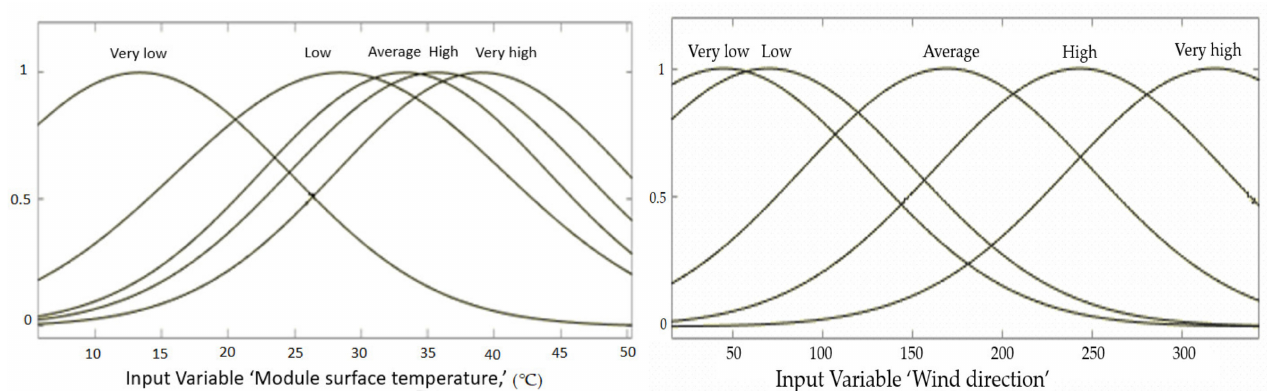
Figure 10. Gaussian MFs for wind direction and module surface